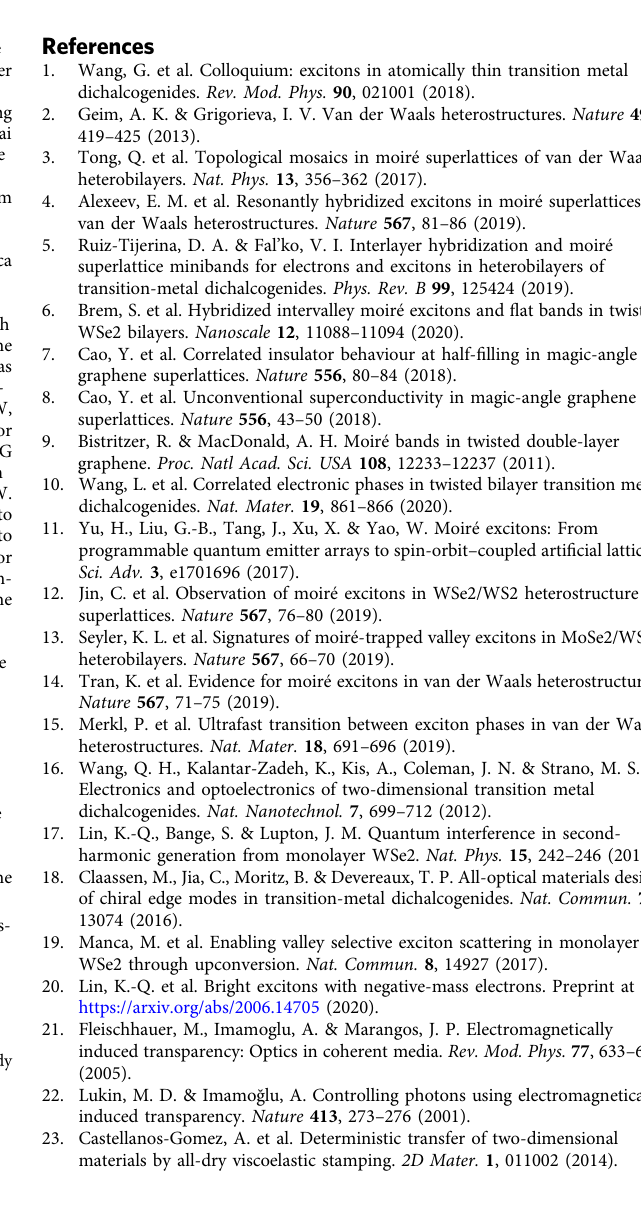
Fig. 5 Recovering quantum interference in twisted-bilayer MoSe 2 at 5 K. Dependence of normalized SHG spectra on excitation energy for monolayer MoSe 2 ( a ) and twisted-bilayer MoSe 2 with a twist angle close to 0° ( b ), with the proposed corresponding excitonic three-level systems illustrated as insets. The condition of an equidistant excitonic three-level system for single-pulse quantum interference is only ful fi lled in twisted-bilayer MoSe 2 and not in monolayer MoSe 2